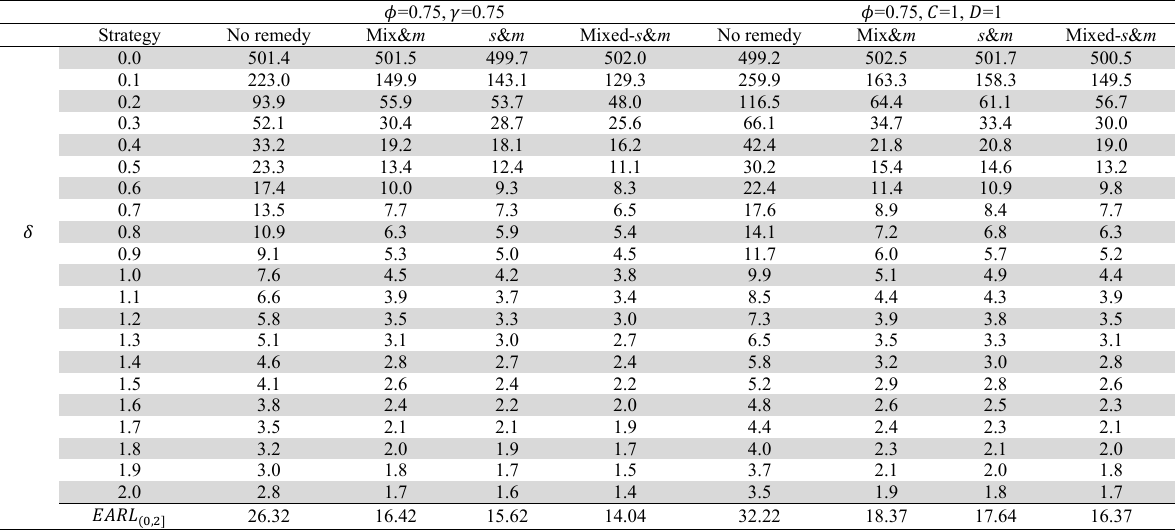
The 𝐴𝑅𝐿 profiles of the HWMA 𝑋(cid:3364) ∗ scheme for different sampling strategies when 𝑛 =5, 𝜆 =0.1, 𝐿 ∗ =2.938, 𝐵 =1, 𝐴𝑅𝐿 with s =3 and m =4